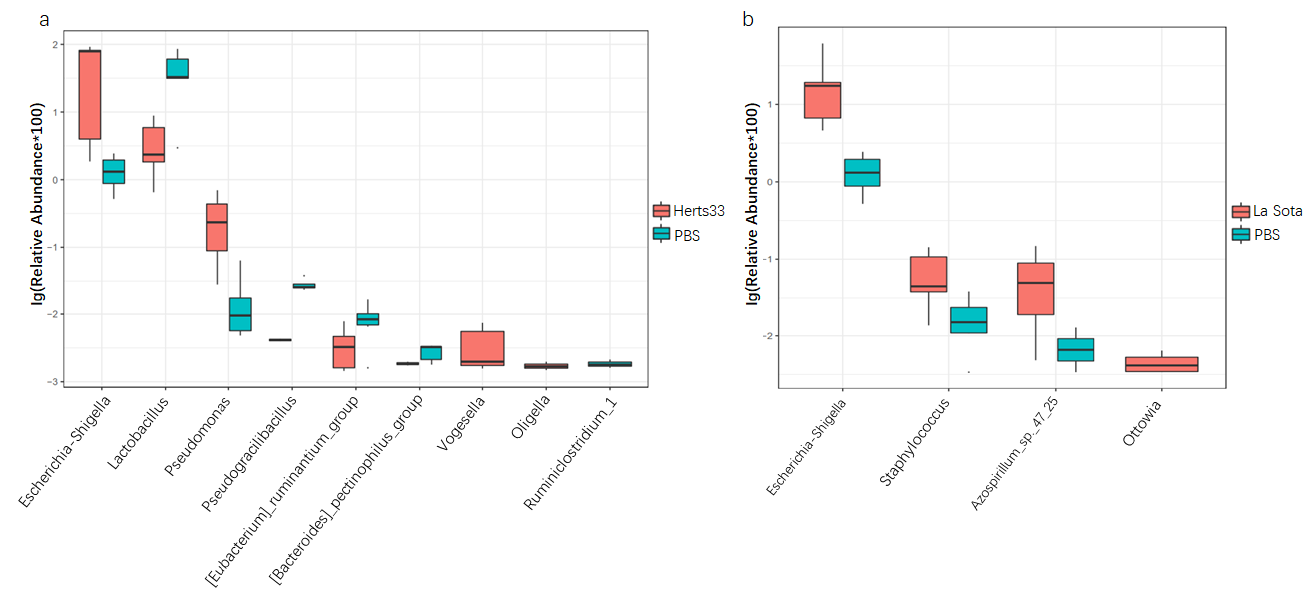
Figure 6. The relative abundance of the top 10 different genera bacteria between NDV challenge groups and the control group ( t −test), expressed as an average percentage of the total: ( a ) Herts33 VS PBS; ( b ) La Sota VS PBS.